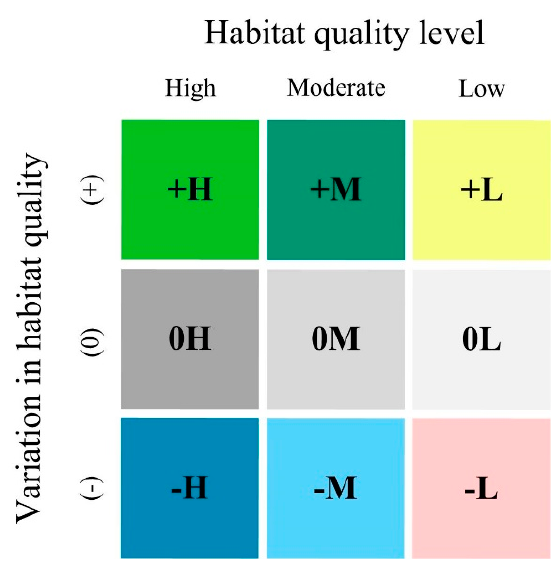
Figure 5. The categories of variation in habitat quality. Note: +H: the high level of habitat quality increased; 0H: the high level of habitat quality did not change; − H: the high level of habitat quality decreased; +M: the moderate level of habitat quality increased; 0M: the moderate level of habitat quality did not change; − M: the moderate level of habitat quality decreased; +L: the low level of habitat quality increased; 0L: the low level of habitat quality did not change; − L: the low level of habitat quality decreased.